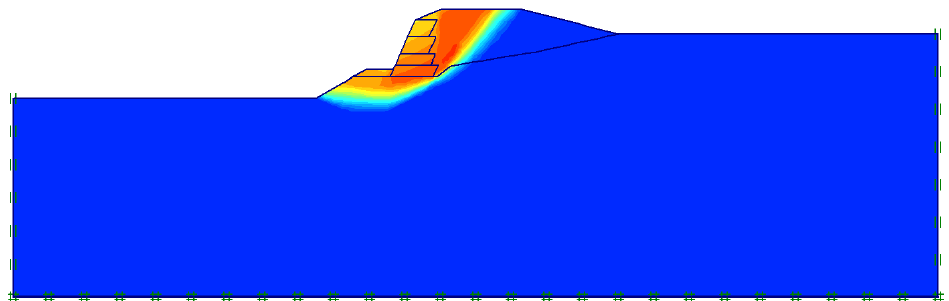
Figure 3. Distribution of the total displacements at failure calculated for the case of homogeneous foundation soils (c ′ 1 = 10 kPa and φ′ 1 = 30°), by means of the phi-c reduction stage. The colorimetric scale is not plotted in the figure because, as is well known, the intensity of displacement at failure calculated by the model is an unrealistic result, due to the elastoplastic constitutive soil model adopted in the simulations. However, this representation is effective in pointing out the volume of materials involved in the failure (volume in which the displacements and the deformation are con- centrated).